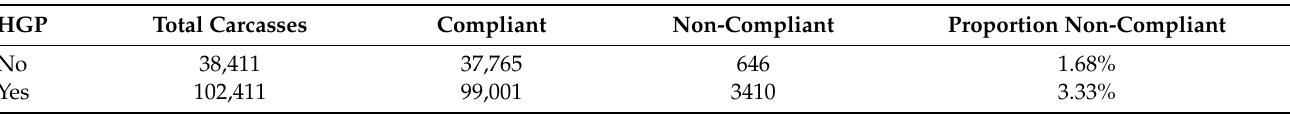
Table 6. Number of carcasses classified as compliant (pH ≤ 5.69) and non-compliant (pH ≥ 5.70), according to hormone growth promotant usage.